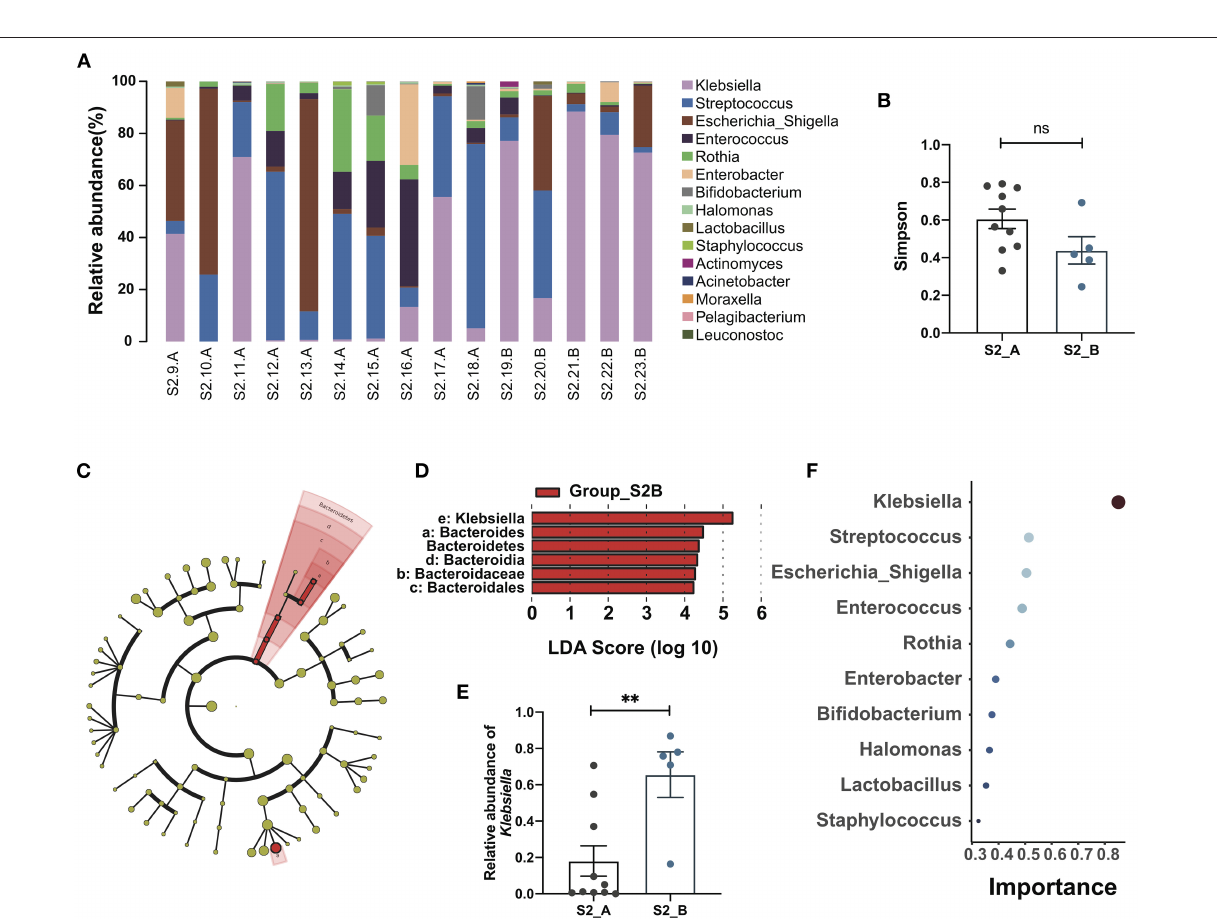
FIGURE 2 | Gut microbiome changes and the importance of Klebsiella in post-Kasai cholangitis. (A) Bar plot showing the relative abundance of the top 15 genera in each sample. (B) Differences between Group S2_A ( n = 10) and Group S2_B ( n = 5). Simpson diversity index values were not statistically significant (Mann-Whitney test). (C) Cladogram of LEfSe analysis showing differential abundances between the two groups. Red nodes, species significantly differentially abundant in Group_S2B. Yellow nodes, microbiota that did not differ significantly between the two groups. Letters are annotated in (D) . (D) Bar plot showing the differential microbiota in Group_S2B ranked by LDA score, indicating that Klebsiella contributed the most to the difference between S2B and S2A. (E) Bar plot showing the relative abundance of Klebsiella in both groups (S2_A, n = 10; S2_B, n = 5). The significance of differences was determined by Mann-Whitney test. (F) Random Forest plot showing the top 10 genera ranked by the importance. The smaller a dot is, the higher its importance.** p < 0.01; ns, not